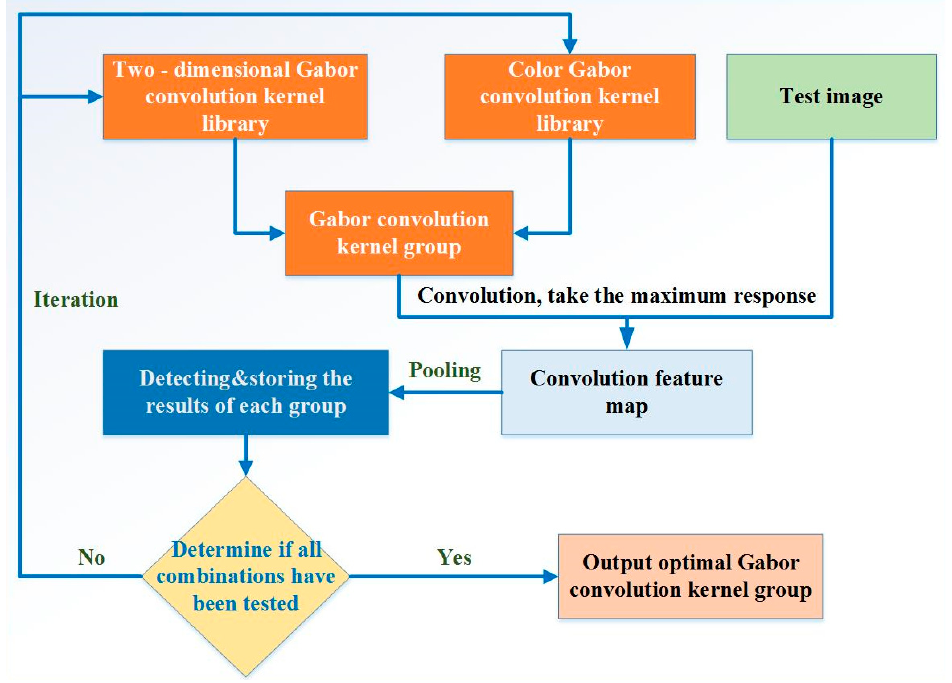
Figure 5. Intelligent screening process for optimal Gabor convolution kernel set.